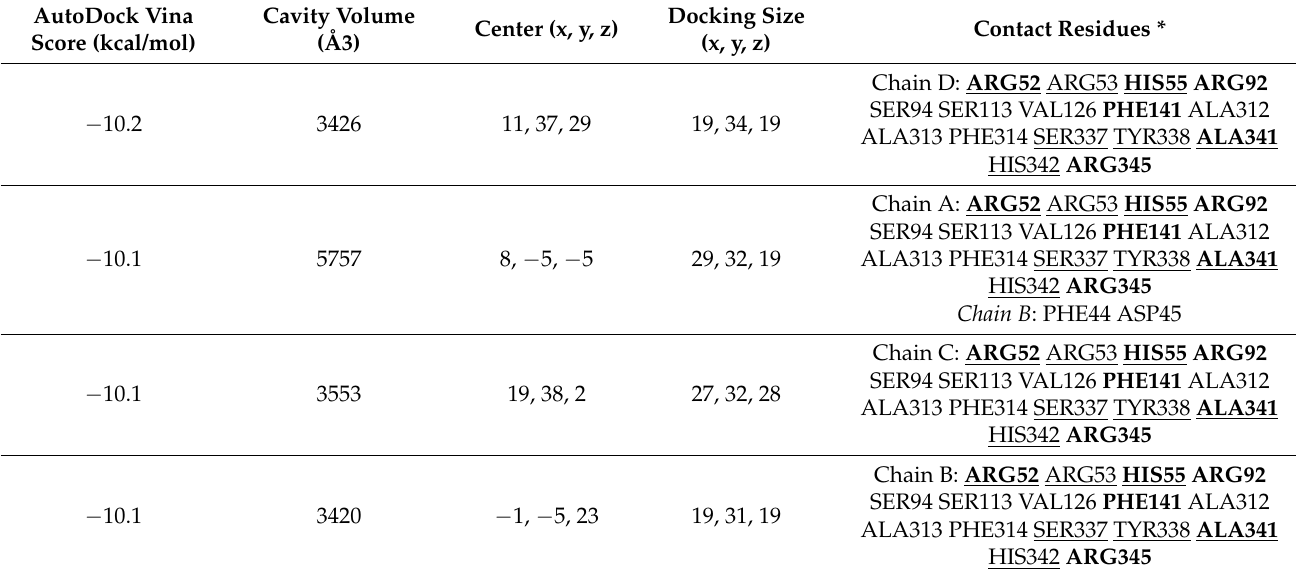
Table 3. Modeled P. aeruginosa catalase (KatA tetramer, PDB code: 4e37) interactions with β